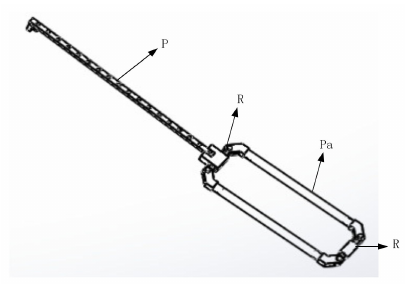
Figure 3. PRPaR branch chain.